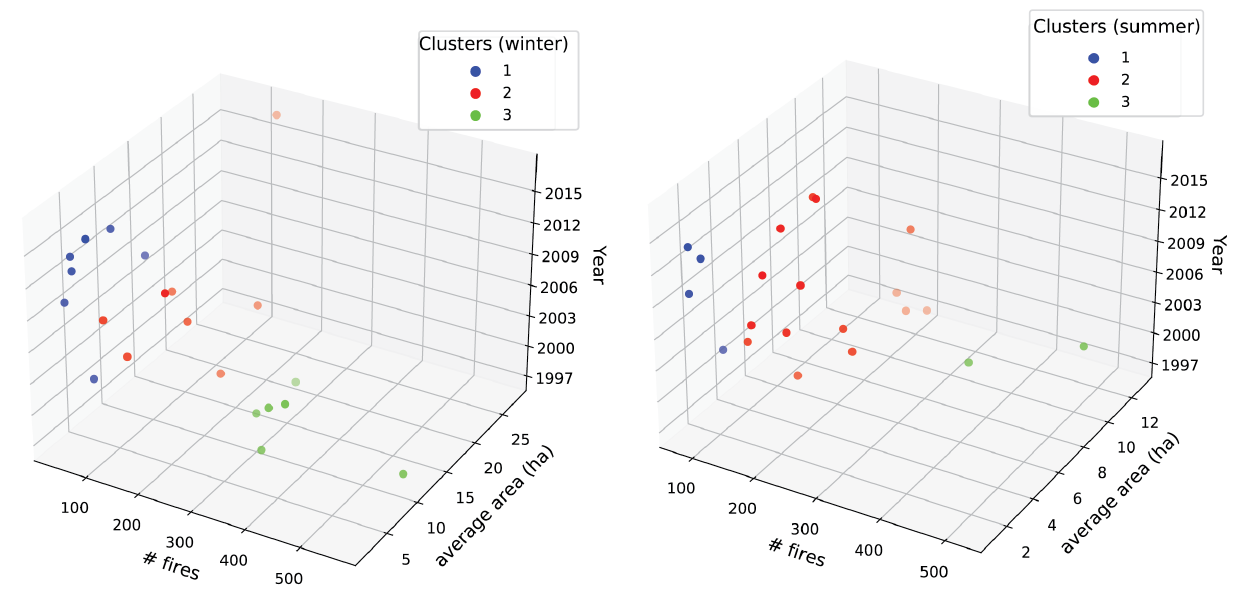
Figure 5. Clustering of the wildfire dataset for winter and summer, resulting from K-means (with K =